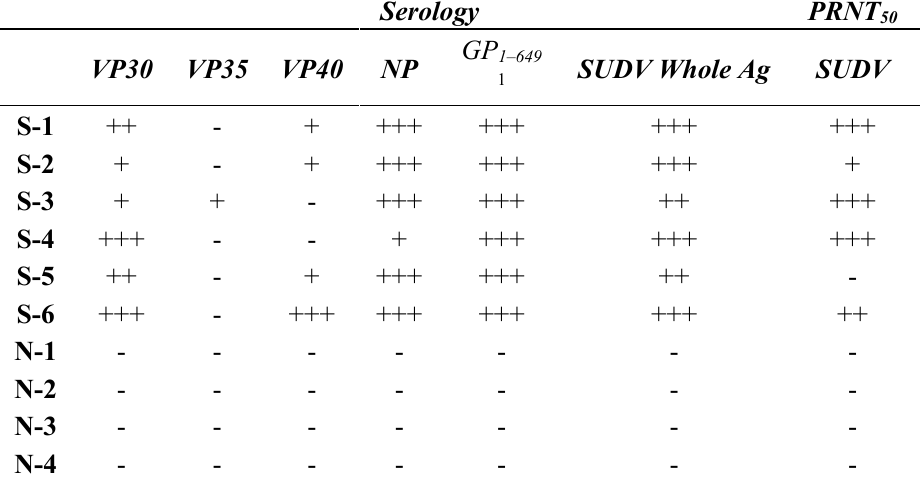
¹ A purified recombinant protein containing the 649 amino terminal amino acid of SUDV GP without the trans-membrane domain. S—Ebola survivors, N—Non-infected control ELISA and neutralization assays results were divided into low (+), medium (++) and strong (+++) immunoreactivity or neutralization capability. For ELISA: (+)—(Lower than 2x cut off value), (++)—(2x cut off value—4x cut off value), (+++)—(Greater than 4x cut off value). For neutralization assay (PRNT50): (+)—(Neutralizes at 1:20